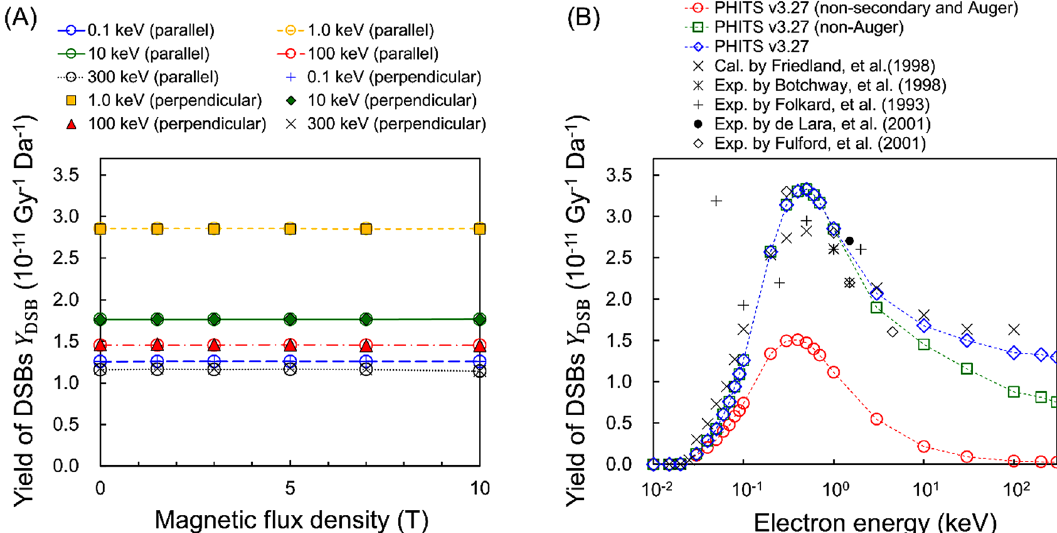
Figure 4. Yields of DSBs for monoenergetic electrons in SMFs. ( A ) shows the Y DSB values for mono-energetic electrons with 0.1–300 keV electrons in the SMFs ( B = 0.0–10.0 (T)). ( B ) shows the Y DSB values without considering secondary electrons, including Auger electrons. The Y DSB values were calculated using PHITS (v. 3.27) and an analytical code for estimating DNA damage yields 25 . These results are compared with other calculation data 31 and experimental data 32–35 .